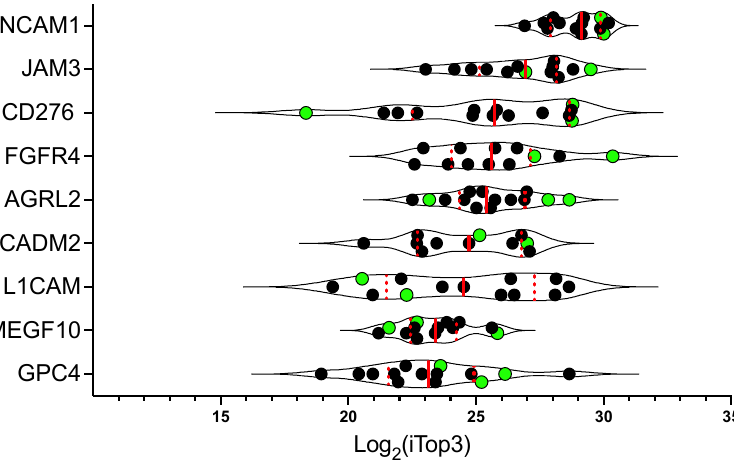
Figure 7. Proteomics abundance distribution of the candidates in the RMS samples. Log 2 (iTop3) of all the samples were plotted for the selected membrane/surface proteins. The proteins were ranked by the median expression from top to bottom. The highest expression was consistently identified in PDXs (green dots), except for L1CAM, which was expressed at lower levels in PDXs compared to cell lines. Shown are the median (red line) and quartiles (dotted red line).